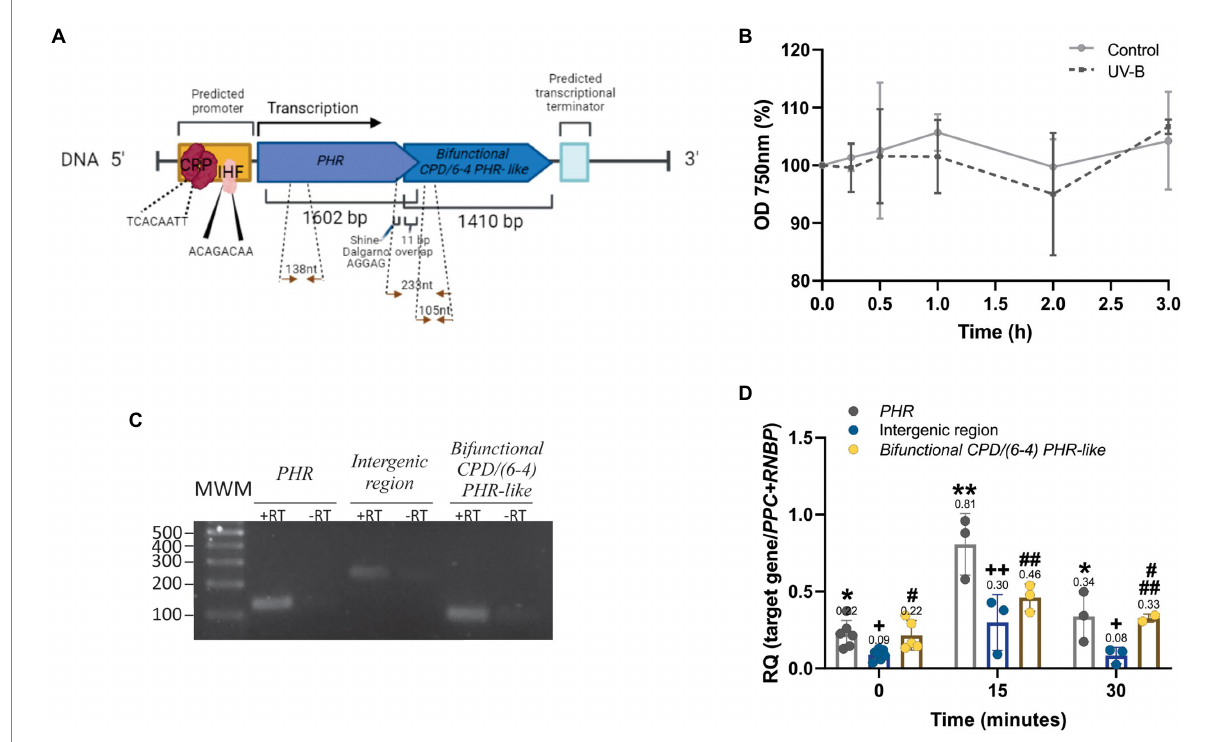
FIGURE 5 Structure and expression of the PHRs operon from Synechococcus sp. PCC 7335. (A) Gene organization scheme of the PHRs operon. Arrows indicate the position of the primers used for RT- qPCR. Nucleotide sequence from the PHRs operon is shown in Supplementary Figure S5. (B) Growth curves of Synechococcus sp. PCC 7335 strain under control or UV-B treatment recorded as optical density (OD) at 750 nm during 3 h. (C) Amplicons from PHR , bifunctional CPD/(6-4) PHR- like and the intergenic region (+RT) were loaded on agarose 2% (w/v) and subjected to electrophoresis. Negative controls without reverse transcriptase ( − RT) were included in the assay. MWM: molecular weight markers. (D) PHRs expression under UV-B treatment. The transcript level of PHR (grey), SyCPD/(6-4) PHR- like (yellow) and the intergenic region (blue) of control and UV-B exposed cultures were evaluated by RT-qPCR. Results were expressed as 2 -( ∆ Ct) using as normalizer the geometric mean of PPC and RNBP genes. Normalization of gene expression to individual reference genes is shown in Supplementary Figure S6. The One- way ANOVA test was used to determine differences for PHR (*), the intergenic region (+) and bifunctional CPD/(6-4) PHR- like (#) transcript levels at different time treatments ( p < 0.05). Equal symbols represent no statistical